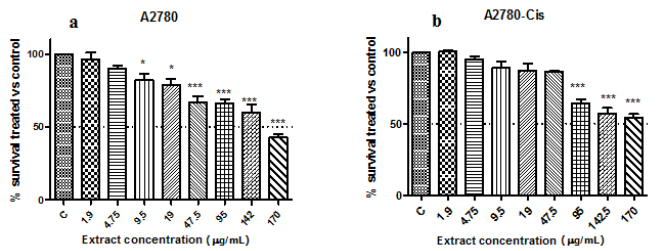
Figure 9. The viability of ovarian carcinoma cell lines treated with Ligustrum ovalifolium fruit extract: ( a ) A2780 and ( b ) A2780-Cis.